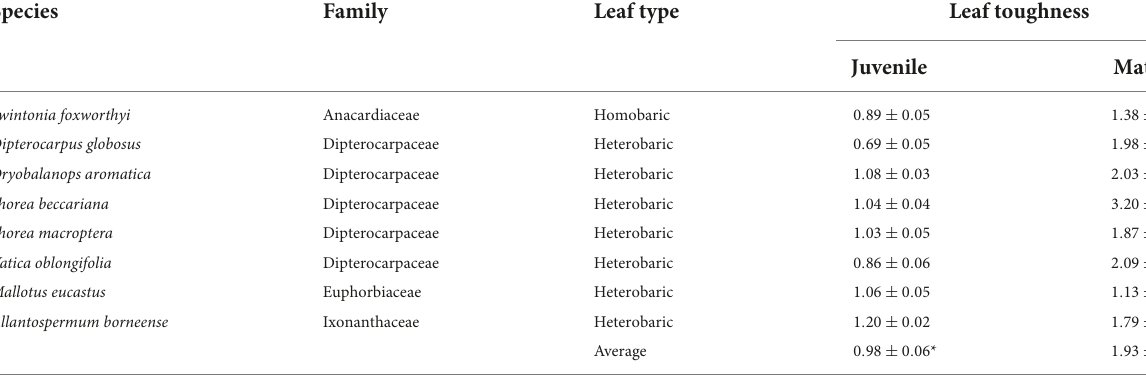
TABLE 1 Comparison of average leaf toughness (MPa) with standard error between juvenile and mature